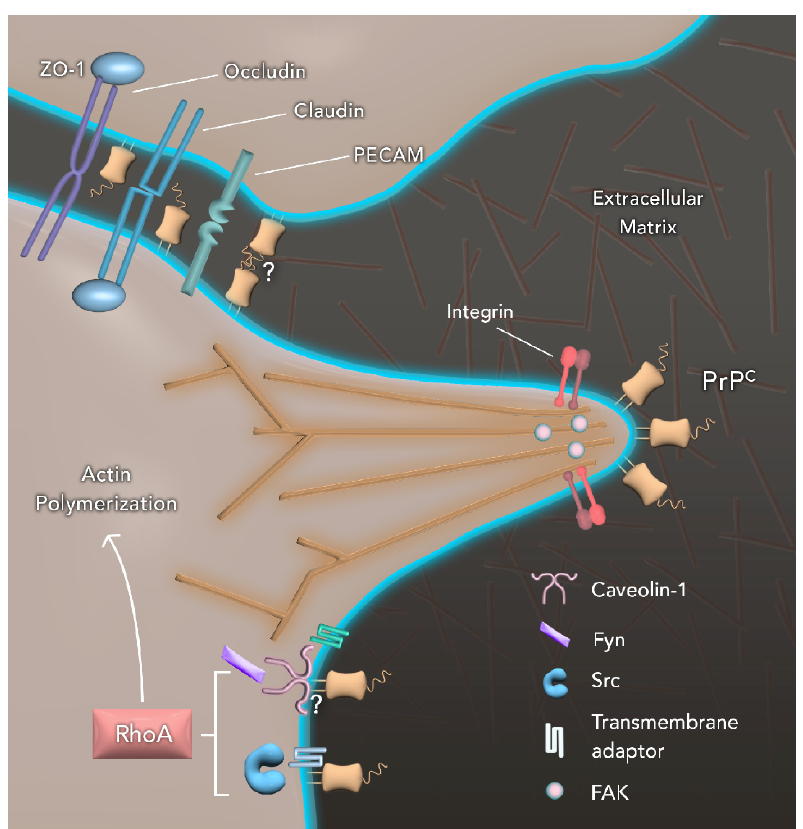
Figure 1. Cellular prion protein (PrP C ) participates in cell motility through interaction with several partners. PrP C can promote the activation of Fyn in a caveolin-1-dependent manner, although the exact mechanism is unknown. Additionally, PrP C can also modulate the activation of Scr. Since PrP C is a glycophosphatidylinositol (GPI)-anchored protein and all the aforementioned proteins are cytosolic, it is postulated the existence of a transmembrane adaptor that acts as an intermediator. Both Fyn and Src are essential for the regulation of Ras homolog family member A (RhoA) activity. In turn, RhoA has a role in the actin polymerization and assembly of F-actin, as well as the formation of cell protrusions such as focal adhesions (FA) with the presence of focal adhesion kinase (FAK), a central regulator of FA. At the tip of FAs is observed an agglomeration of PrP C , as well as integrins and, since PrP C is known to interact with molecules from the extracellular matrix (ECM), it is postulated that both proteins have an important role in adhesion to the extracellular matrix during cell movement. Additionally, PrP C is also known to modulate adhesiveness, being found at the tip of FA and co-localizing with key proteins in cell–cell adhesion domains such as occludin, claudin, PECAM and ZO-1. It is not yet clear if PrP C can interact homophilically with other PrP C molecules from the neighboring cells, although a co-localization is observed.